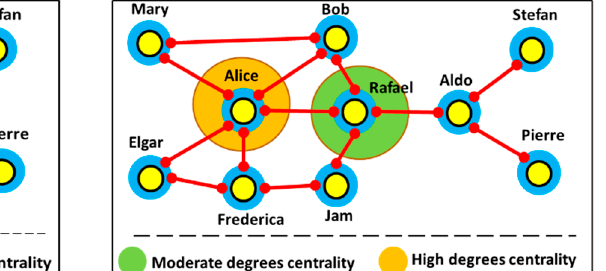
( b ) Pictorial overview of the degree centrality (DC) in a SN.